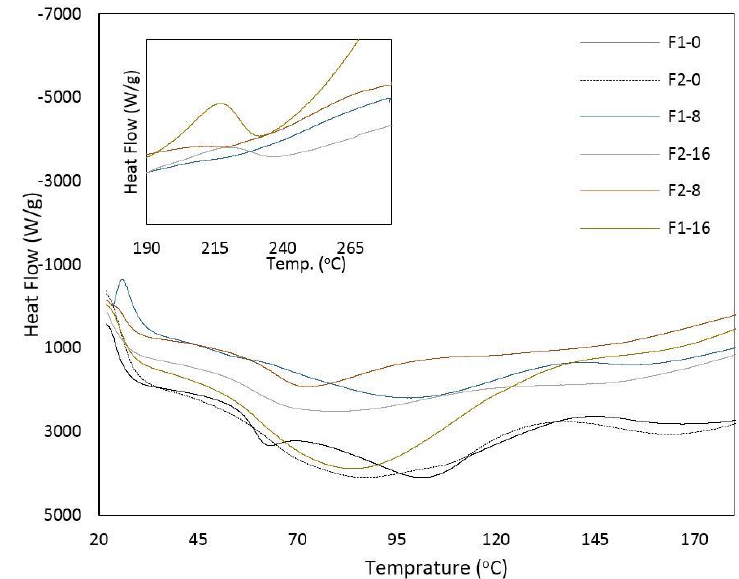
Figure 4. Heat flow vs. temperature of composite films from ASC-g-P(MMA-co-EA) with/without GO contents, in Differential Scanning Calorimeter (DSC) heating phase with the rate of 10 °C min −1 in an aluminum pan. To clarify, curves associated with the decomposition transition of GO contents were demonstrated in the same graph happening within the temperature ranges between 190–280 °C) in samples with high GO contents.